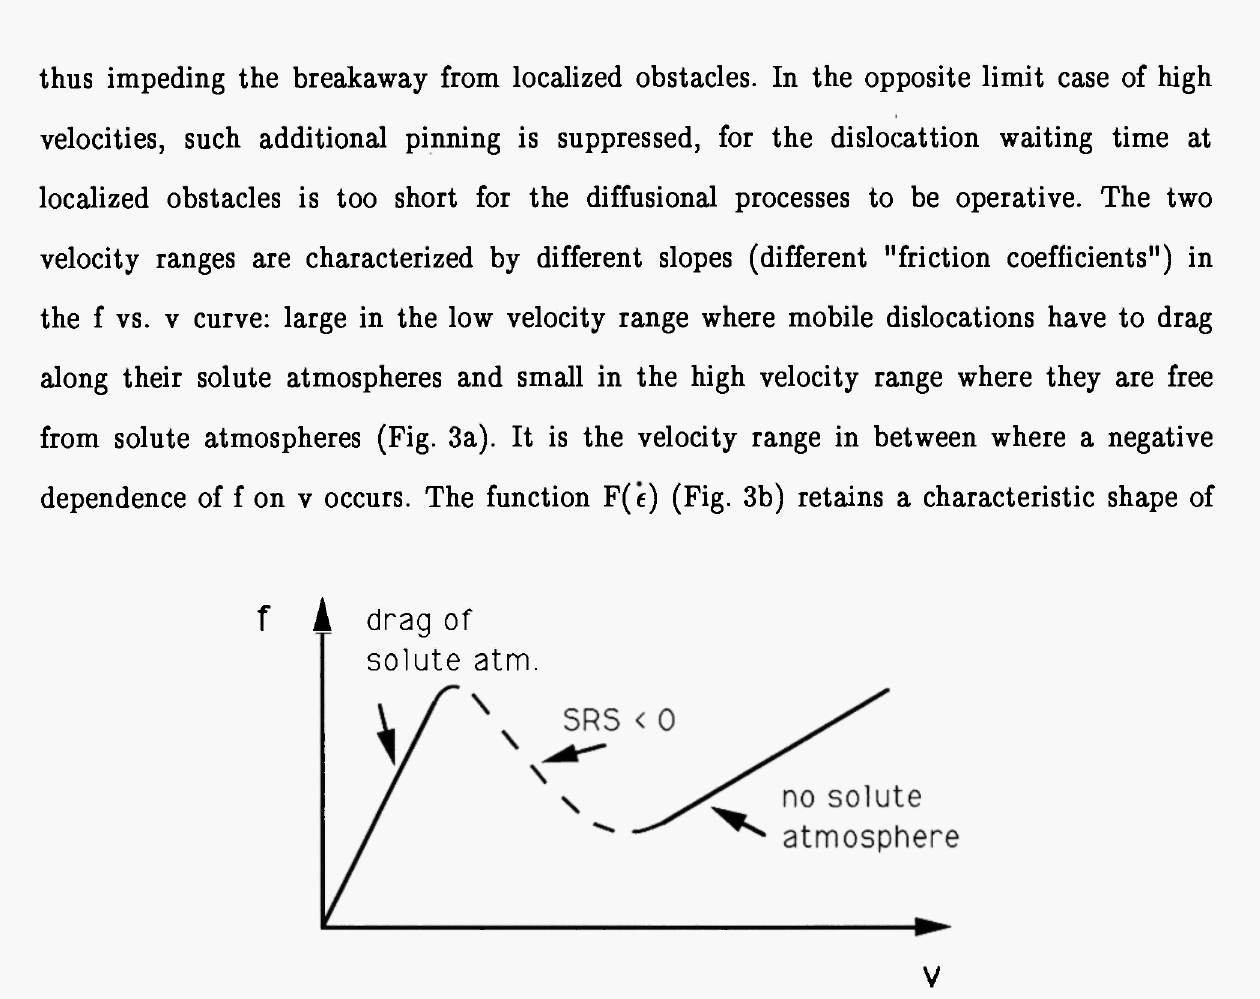
Fig. 3. Thermal component of stress in a dynamic strain ageing alloy (schematic), (a) "Friction stress" f as a function of dislocation velocity v. The dotted portion of the curve gives rise to a negative strain rate sensitivity.